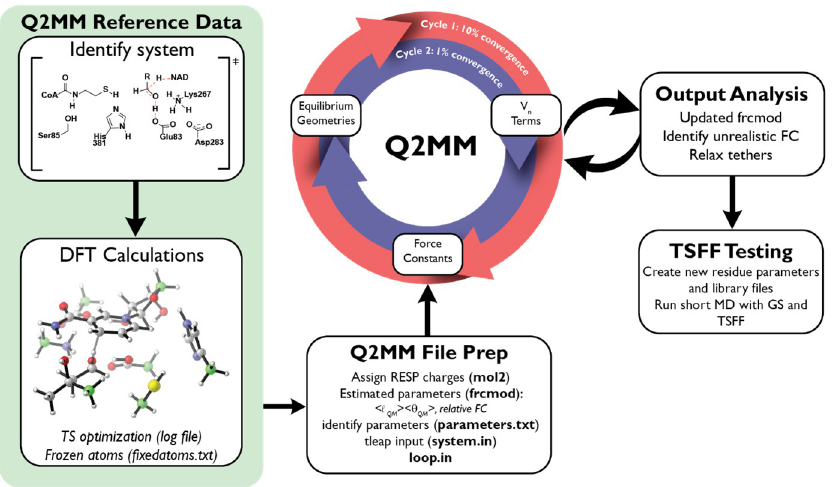
Fig 2. Q2MM workflow the parametrization of TSFFs for enzymatic reactions. The Q2MM system set up starts from the top left by first describing relevant system for the enzymatic reaction of interest, followed by reference DFT data calculation, which is included in the input files required by the program allowing it to iteratively develop a TSFF.